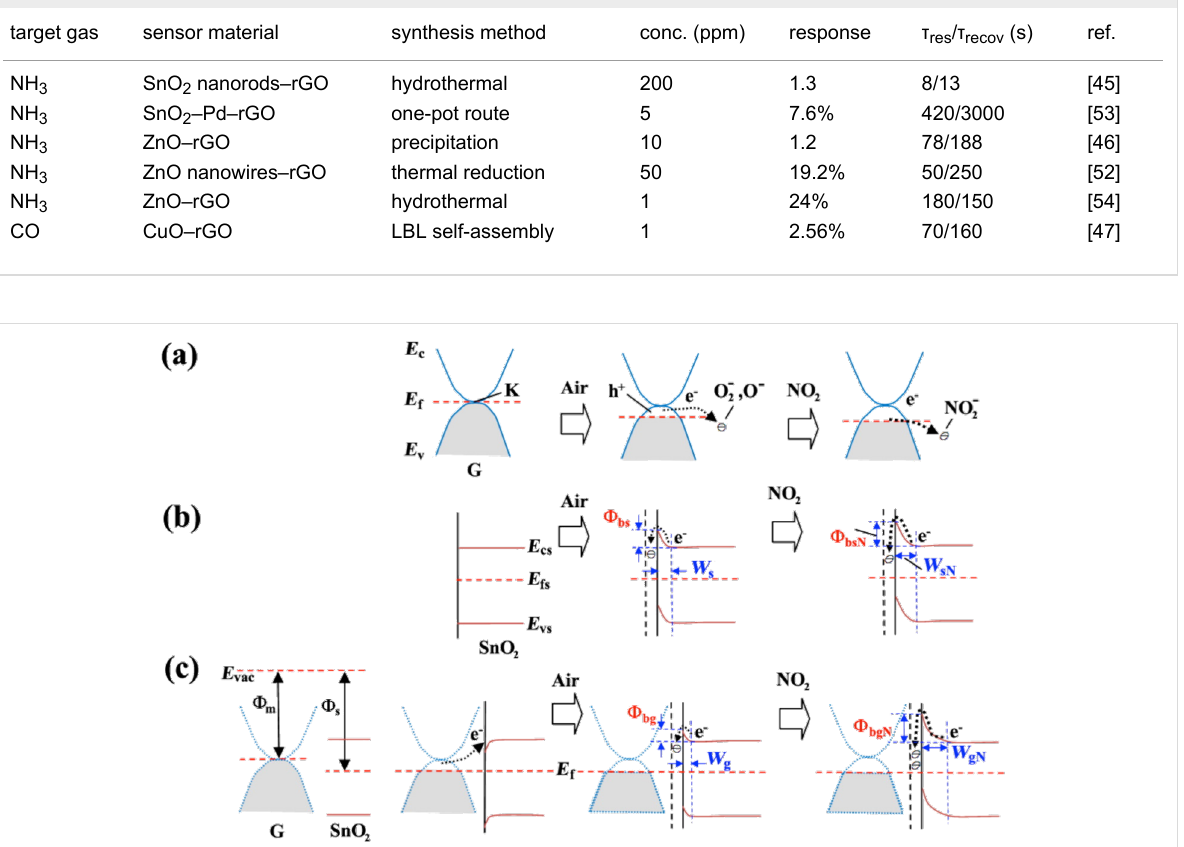
Table 1: Gas-sensing performance of graphene/metal-oxides sensors for reducing gases at room temperature. target gas